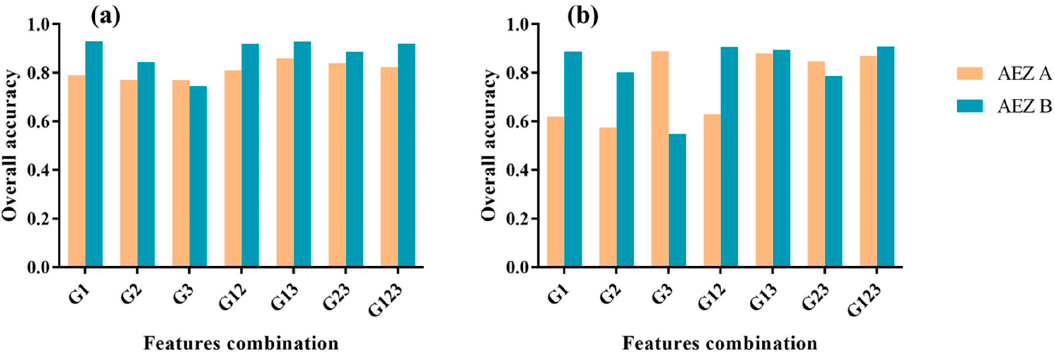
Figure 6. The overall accuracy of different feature combinations in ( a ) 2017 and ( b ) 2018.